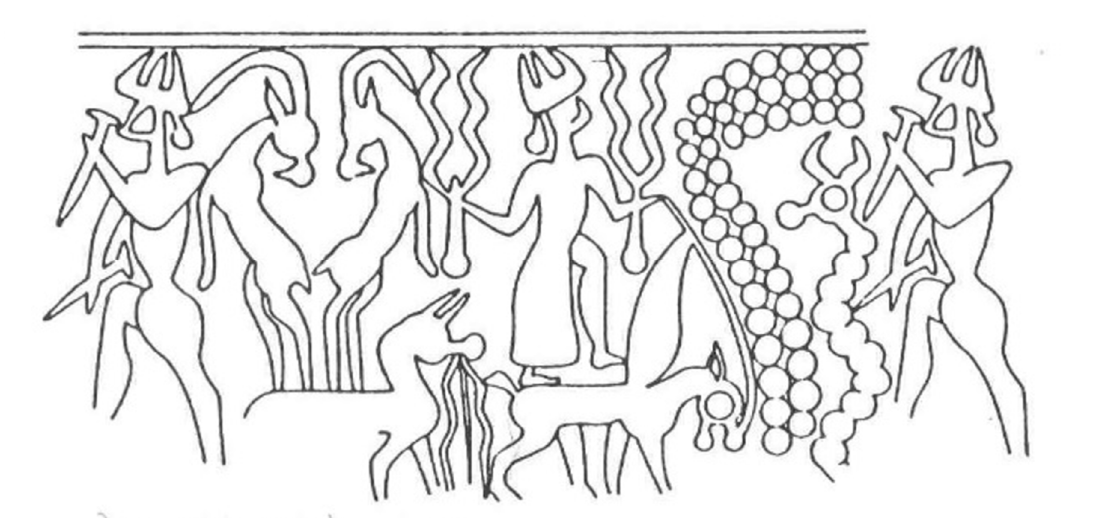
Figure 11. Splash of dots before the weather god holding lightning forks who stands on a lion dragon (Stein 1988: Figure